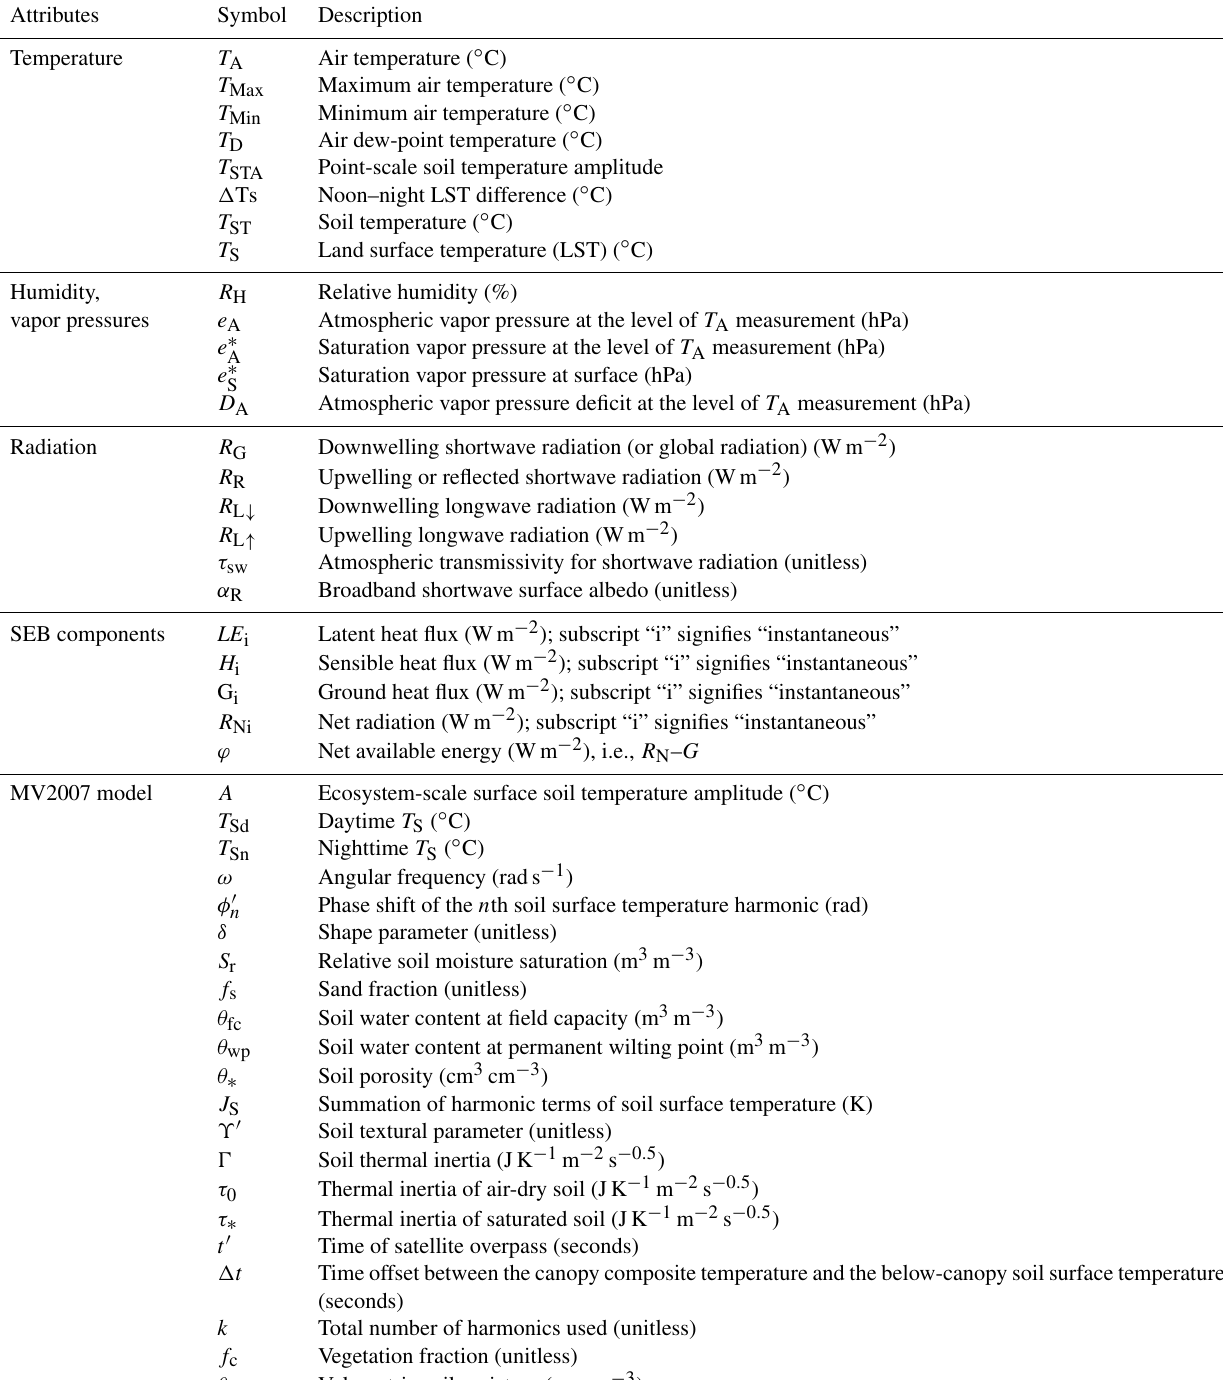
Table A1. A list of symbols, their descriptions, and units used in the present